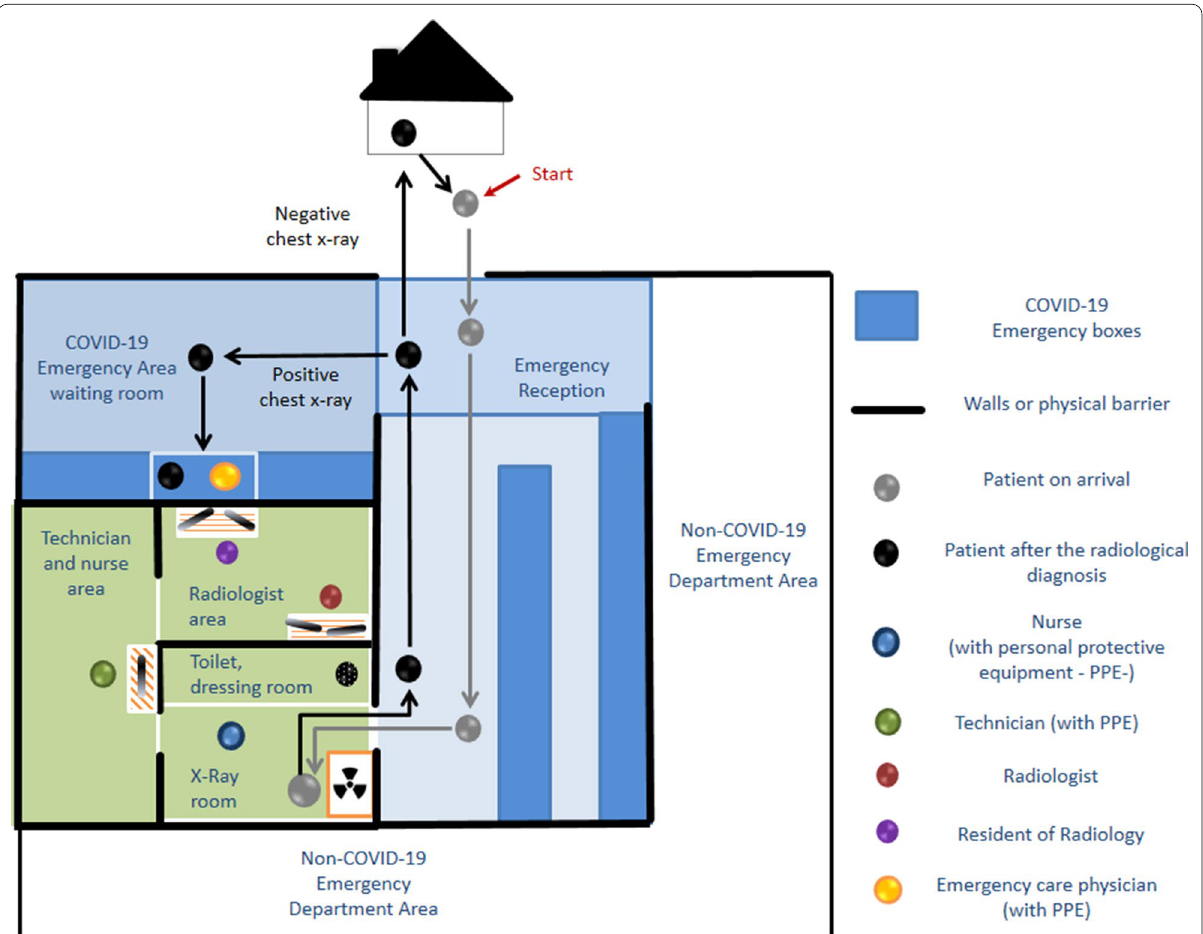
Fig. 1 Primary care high-resolution radiology service (pcHRRS) workflow. The pcHRRS was integrated in the emergency radiology area (green background) and in the COVID-19 area at the emergency department (blue background). PPE: Personal protective equipment; RDR: